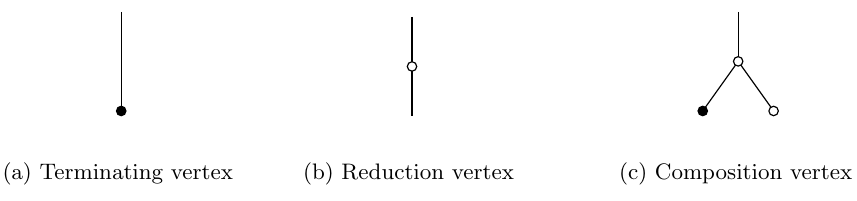
Figure 5: Graphical representations of the types of vertices in the progress tree of Algorithm α ( x, k )